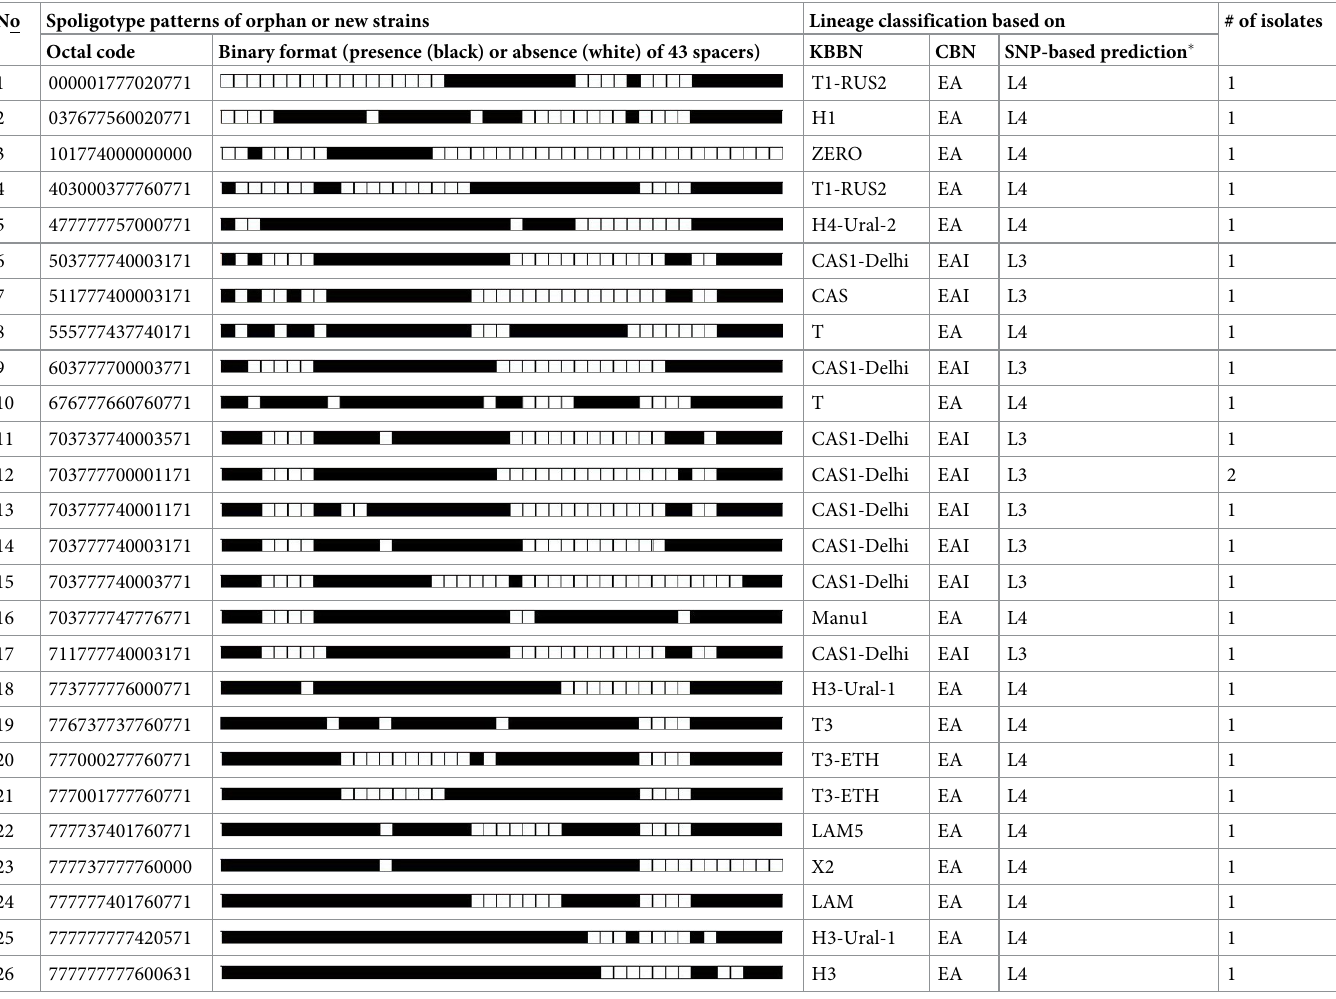
Table 2. Descriptions of all orphan and new spoligotype patterns (n = 26) that were identified from 27 clinical samples collected from pulmonary TB and cervical TB lymphadenitis patients recruited at selected health facilities in Ethiopia in the years of 2016/17.